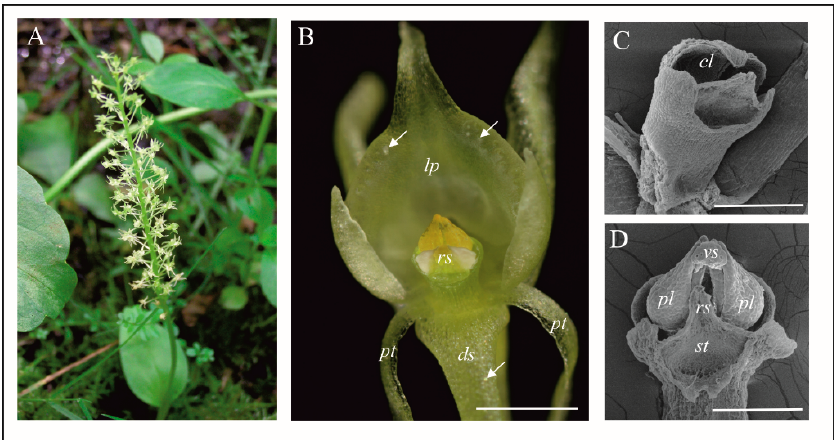
Figure 1. General plant and flower morphology of Malaxis monophyllos . ( A ) flowering plant in the natural habitat of Wigry National Park; ( B ) flower in optimum of anthesis, arrows—indicate raphides in the cells of the labellum; ( C ) gynostemium after removing the pollinaria; ( D ) gynostemium with pollinaria (SEM). Scale bars: 500, 200, 200 µm. cl —clinandrium, ds —dorsal sepal, lp